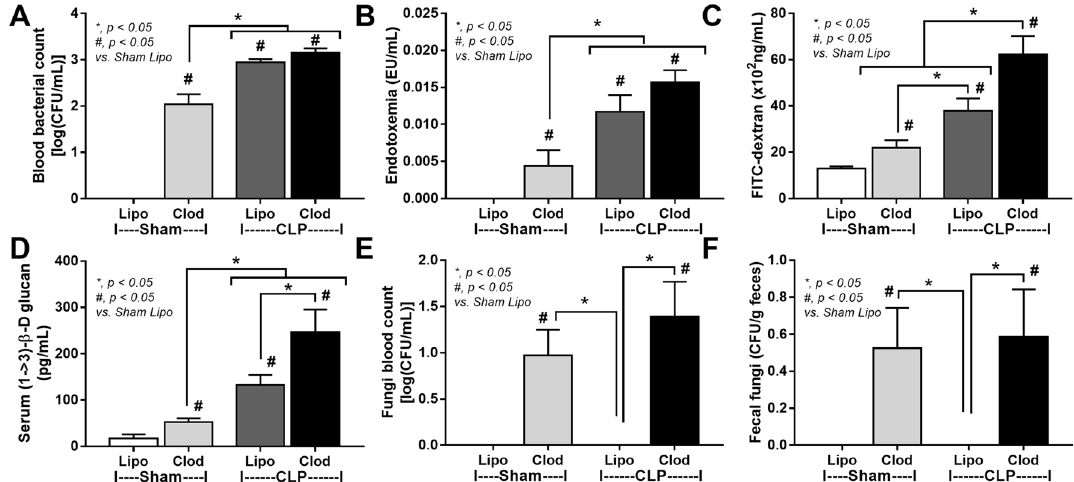
Figure 5. Characteristics of mice with liposomal clodronate (Clod) or liposome control (Lipo) after sham or cecal ligation and puncture (CLP) surgery as evaluated by blood bacterial count ( A ), endotoxemia ( B ), gut permeability defect (FITC-dextran assay, serum (1 → 3)-β-d-glucan and fungal culture from blood) ( C – E ) and fungal abundance in feces ( F ) are demonstrated (n = 6–8/group).